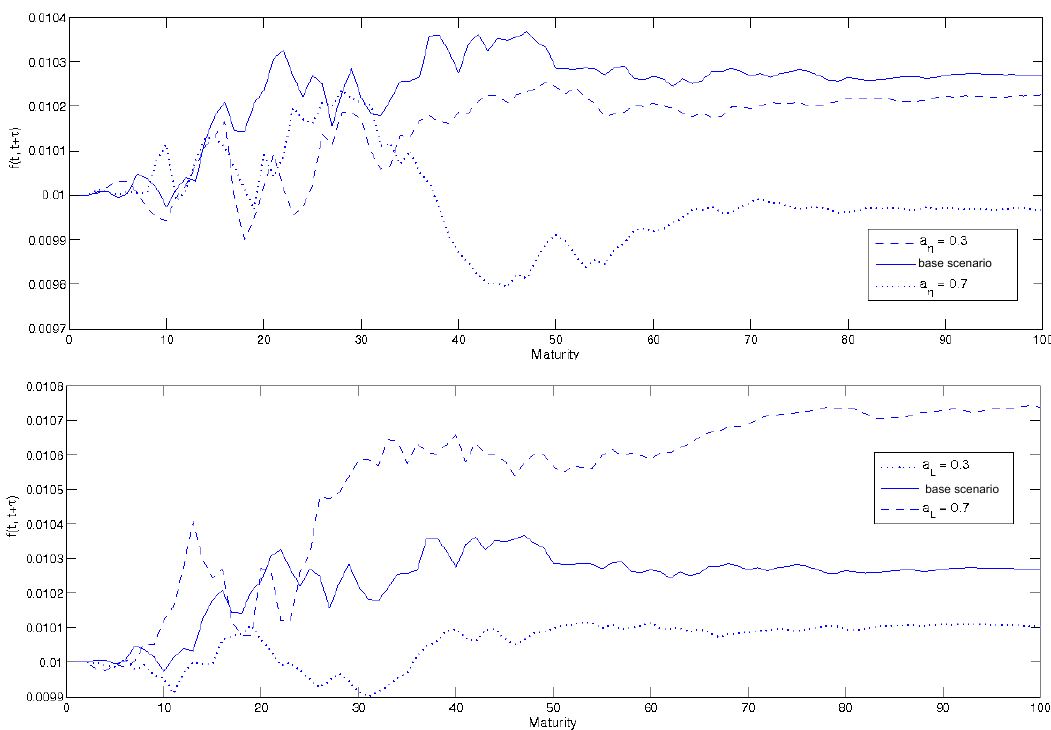
Figure 9. Forward instantaneous rate for various levels of correlation coefficient ω .